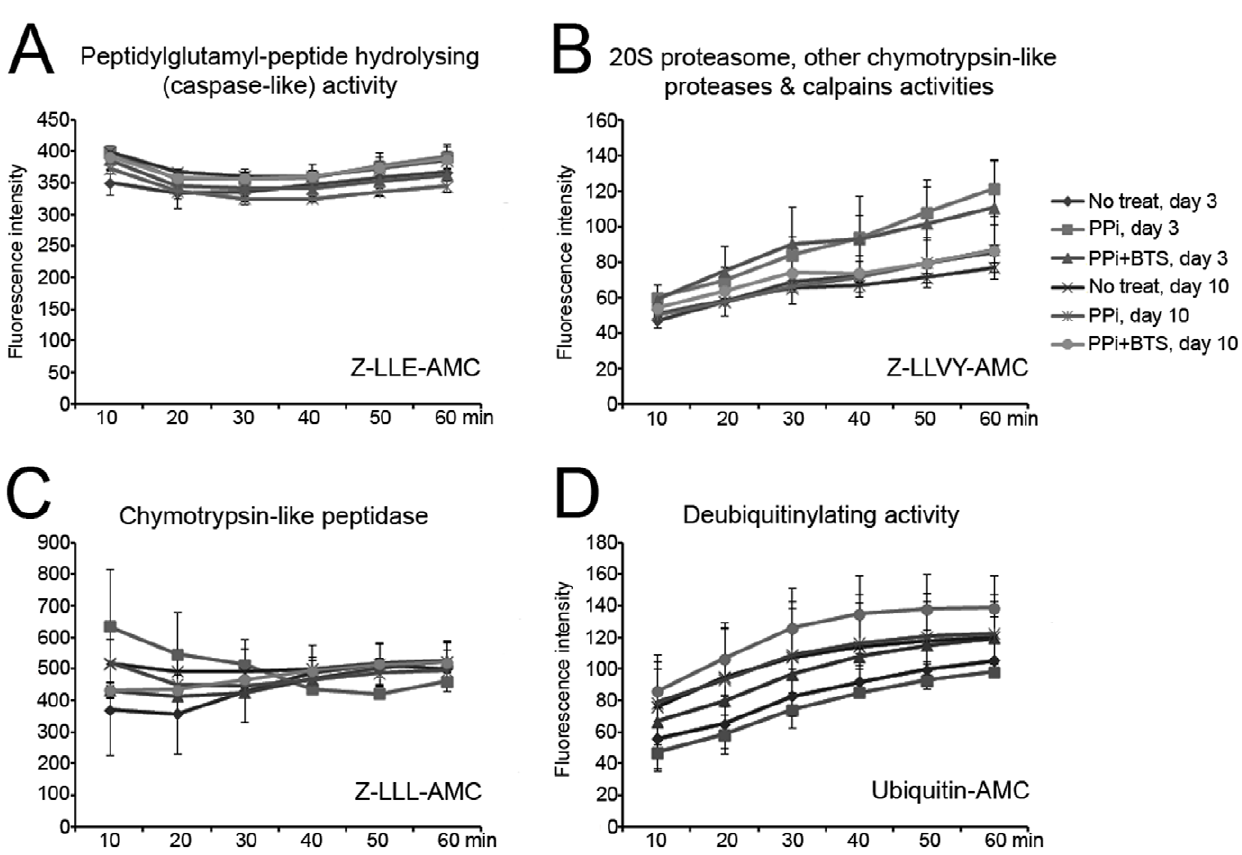
Figure 7. Effect of PPi on proteasomal enzymatic activities of stored boar spermatozoa. Fresh boar spermatozoa were stored in BTS with/ without 10 m M PPi for 3 or 10 days (No treat/PPi + BTS). Proteasomal proteolytic and deubiquitinating activities were measured using specific fluorometric substrates Z-LLE-AMC (A), Z-LLVY-AMC (B), Z-LLL-AMC (C) and ubiquitin-AMC (D). In a separate treatment group, PPi (10 m M) was added before measurement to spermatozoa preserved without PPi in BTS (PPi). The emitted fluorescence (no units) was measured at multiple time points to follow the kinetics of the reaction (Excitation 380 nm; emission 460 nm). Experiments were repeated three times. Values are expressed as the mean of fluorescence intensity 6 SEM.